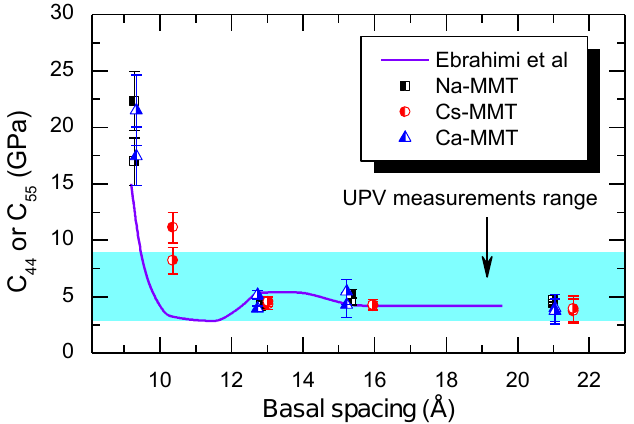
Figure 8. The C 44 and C 55 elastic constants as a function of basal layer spacing. The shear of hydrated MMT along the direction perpendicular to the mineral plane is mainly controlled by the relative torsion of bonded atoms. The variations of C 66 with basal spacing are shown in Figure 9. With the increase of interlayer water content, C 66 decreases continuously, which is mainly due to the increase of interlayer water contribution in the weak shear zone. Considering that the ratio of width to height of a true MMT lamella is very large (about 100:1 to 1000:1), shear along the direction of orthogonal to the mineral plane is almost impossible, so the variations of C 66 will not be discussed here.